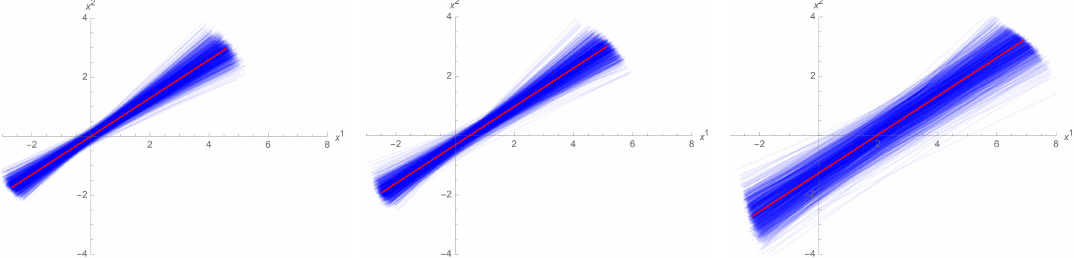
Figure 6 . Bundle of worldlines resulting from the random extraction of 1000 points from a Gaussian distribution of the form (4.33), centred in ( p 1 , p 2 , q 1 , q 2 ) with variance σ = 0 . 01 . The plots show the projection of the worldlines in the plane ( x 1 , x 2 ) . From left to right, the distributions are centred in: ( p 1 , p 2 , q 1 , q 2 ) = (1 , 1 , 0 , 0) , ( p 1 , p 2 , q 1 , q 2 ) = (1 , 1 , 1 , 1) , ( p 1 , p 2 , q 1 , q 2 ) = (1 , 1 , 4 , 4) , corresponding to ( v 1 , v 2 , B 1 , B 2 ) = (0 . 76 , 0 . 49 , 0 , 0) , ( v 1 , v 2 , B 1 , B 2 ) = (0 . 76 , 0 . 49 , 0 . 58 , 0 . 06) , ( v 1 , v 2 , B 1 , B 2 ) = (0 . 76 , 0 . 49 , 2 . 32 , 0 . 24) respectively. The red worldlines correspond to the center of the distributions. Each worldline has an opacity of 0 . 05